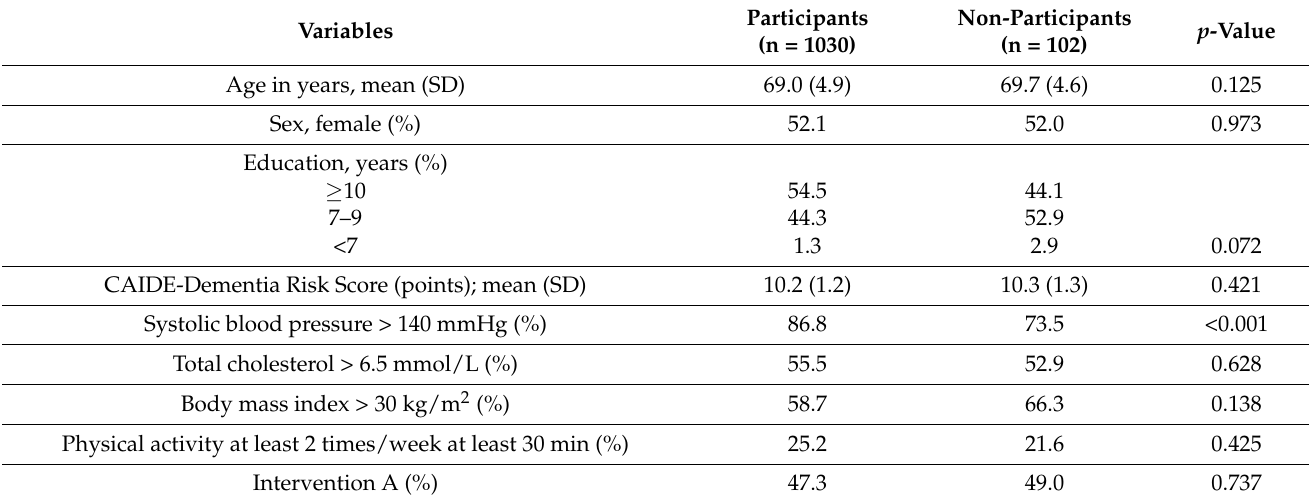
Table 2. Characteristics of participants and non-participants of the AgeWell.de